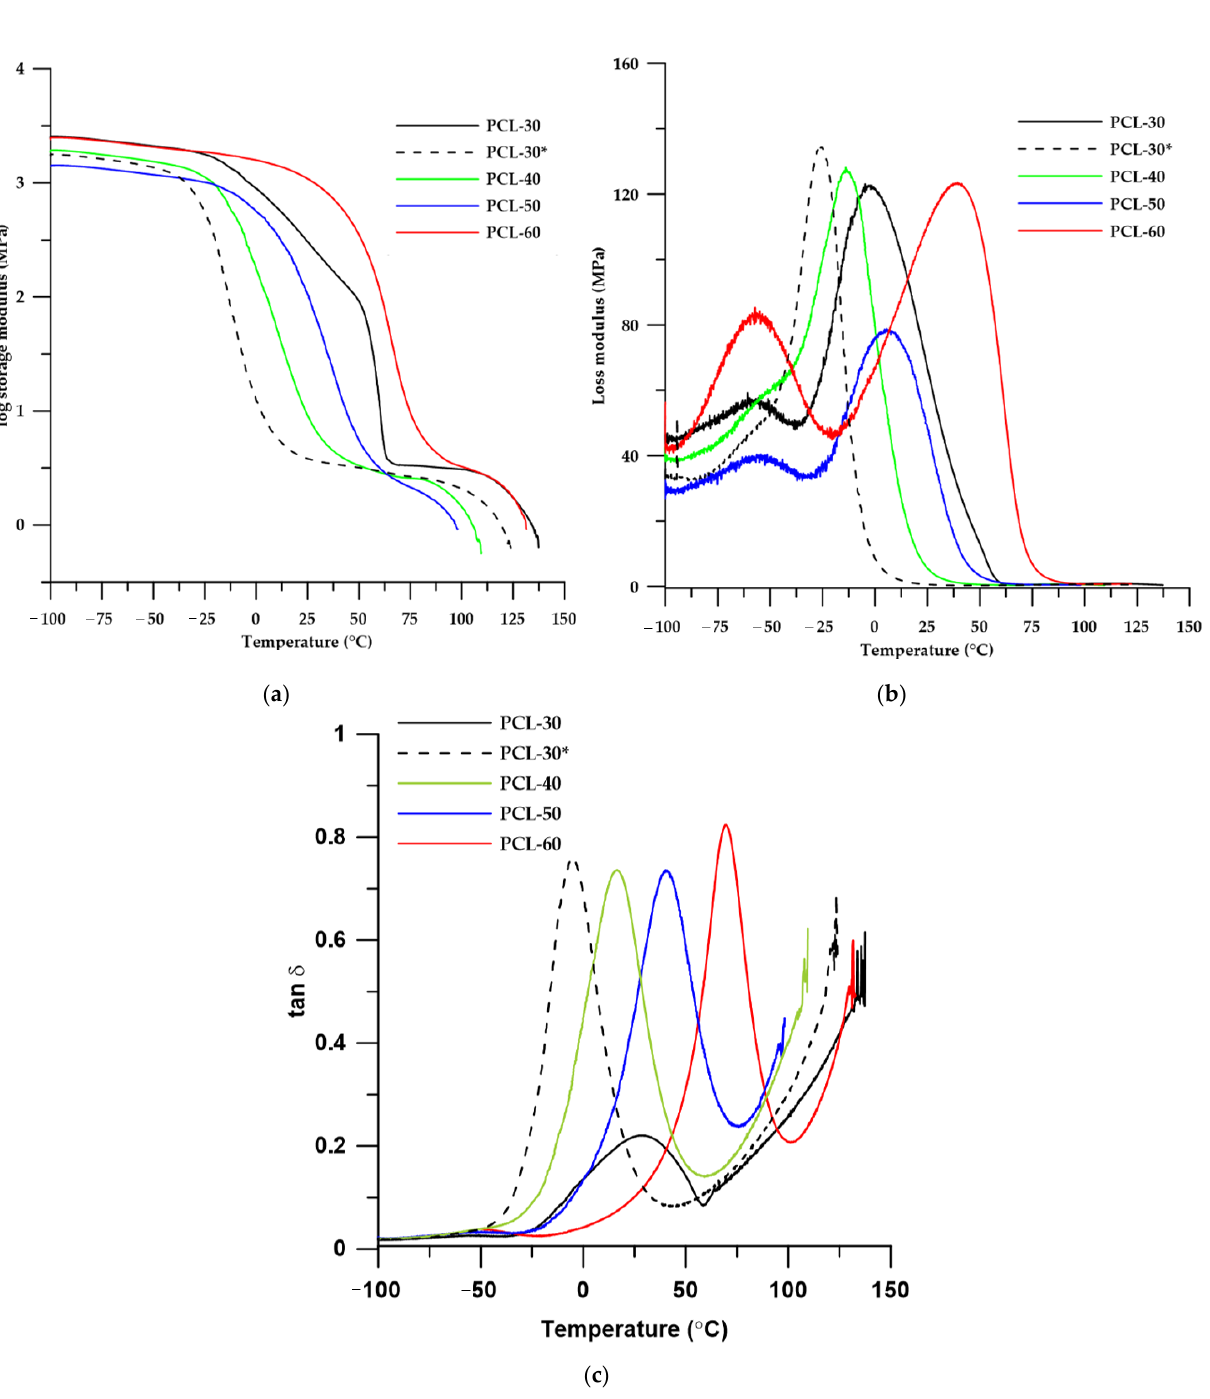
Figure 9. Temperature dependence of storage modulus ( a ), loss modulus ( b ) and tan δ ( c ) of synthe- sized SPTURs.